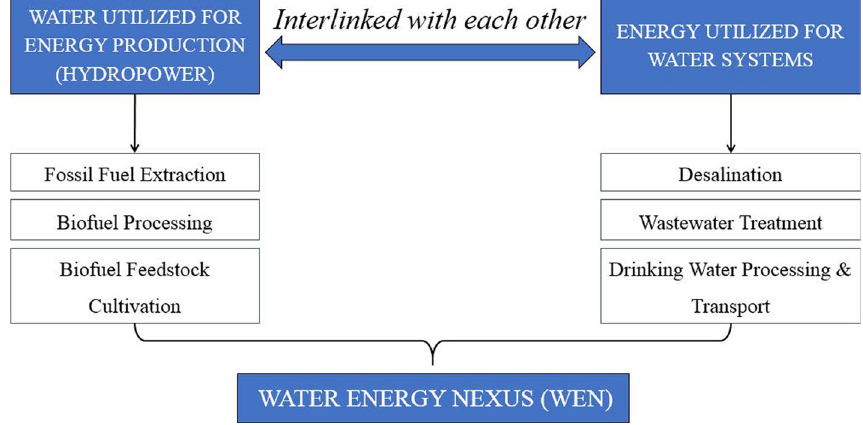
Fig. 1 Water and energy inter-